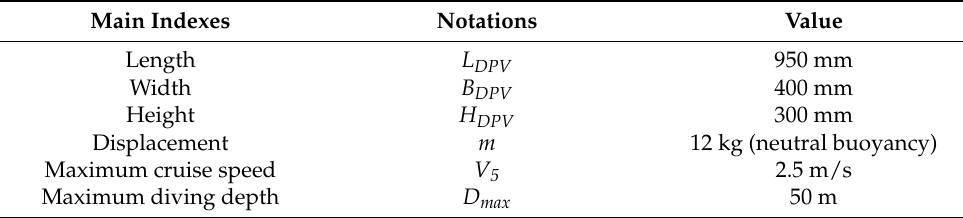
Table 1. Parameters of four typical